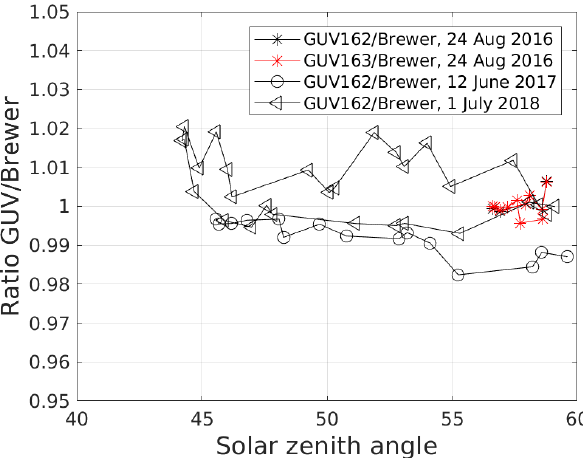
Figure 4. Ratio of the GUV and Brewer total ozone column at So-